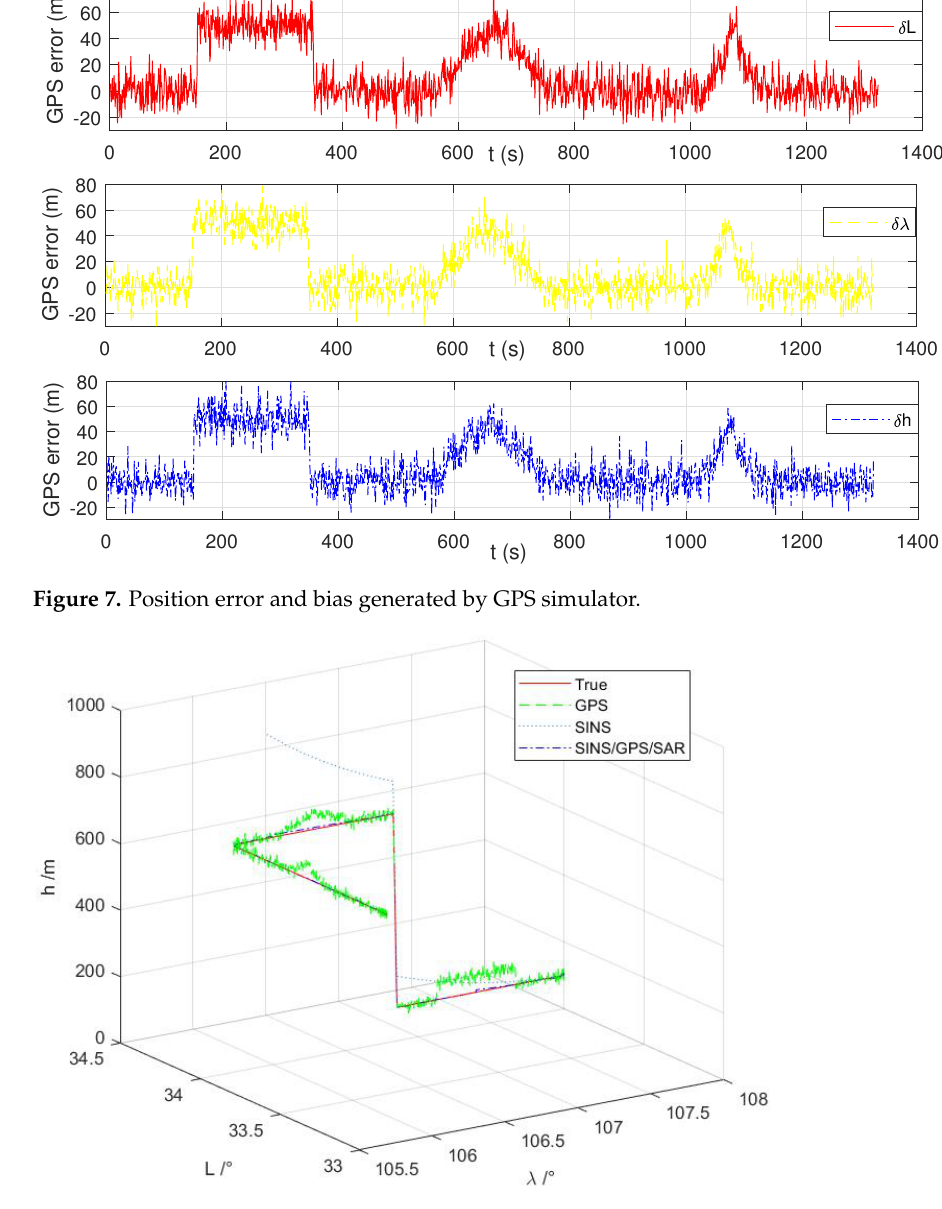
Figure 8. 3D trajectory